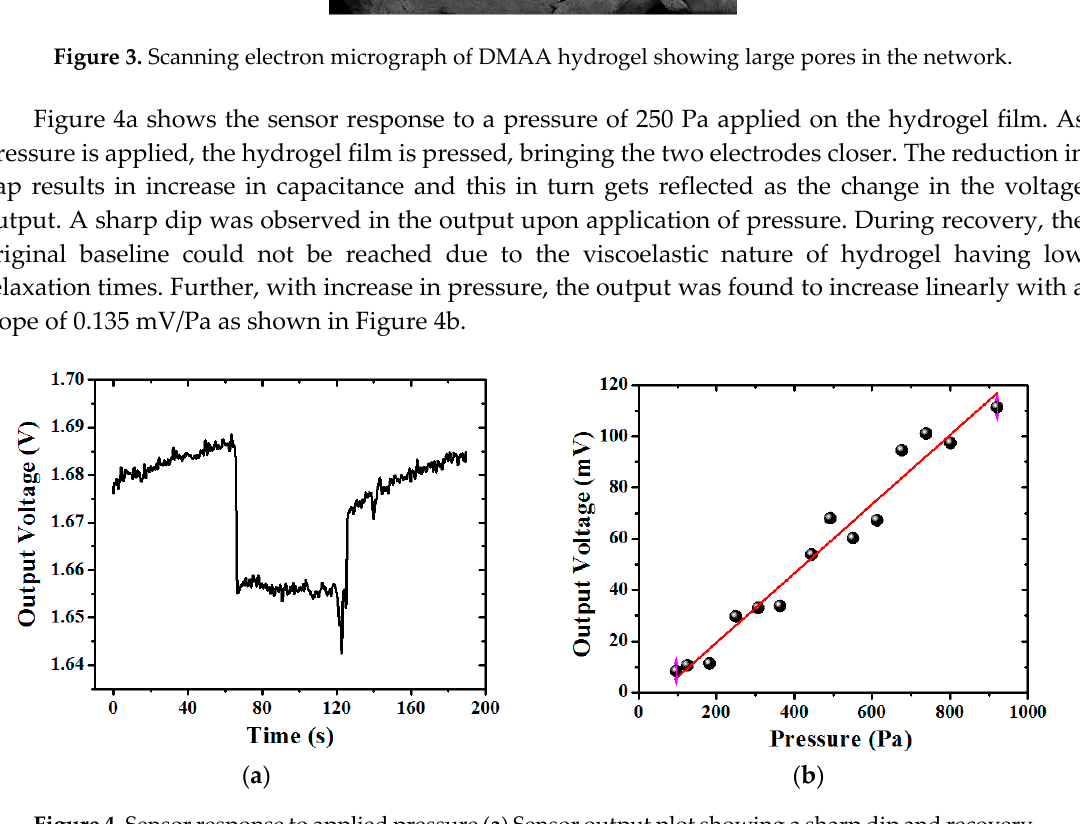
Figure 4. Sensor response to applied pressure ( a ) Sensor output plot showing a sharp dip and recovery in response to the application and removal of a pressure of 250 Pa, respectively; ( b ) Sensor response showing a linear increase in the output with increase in applied